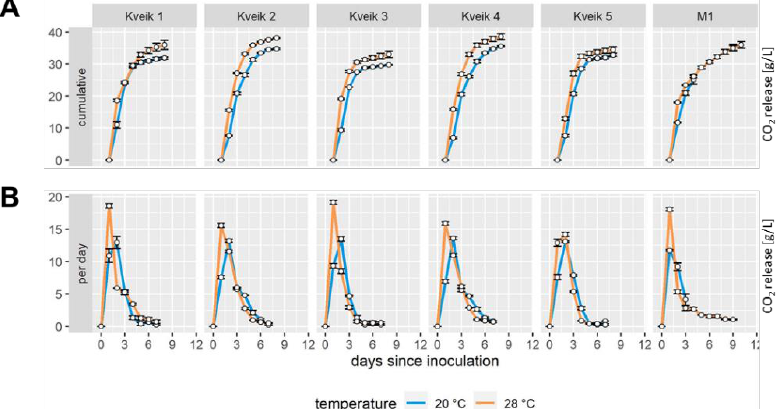
Figure 2. Fermentation characteristics of Kveiks . ( A ). Fermentation curves of the indicated strains and M1 control based on CO 2 -release and concomitant mass loss, which was measured daily. ( B ). Amount of CO 2 -release per day illustrates the fermentation intensity of the strains. White circles mark the mean value of three replicate fermentations; error bars are the standard error of the mean.